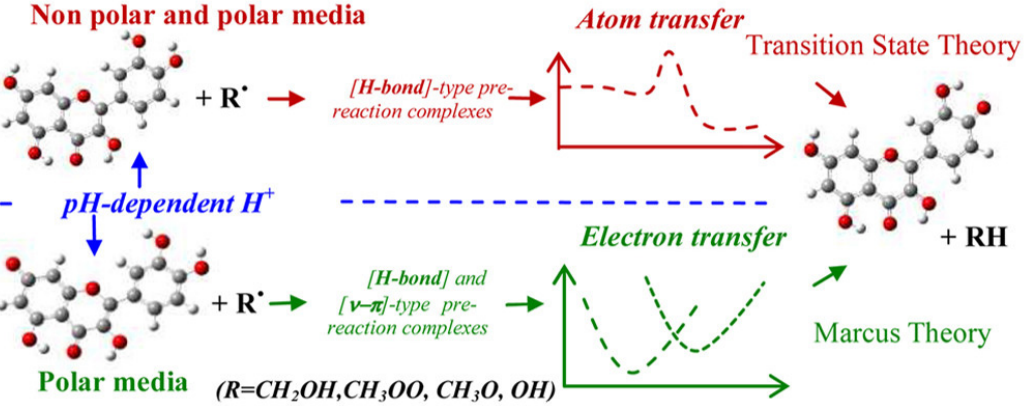
Figure 6. Schematic depiction of the hydrogen atom transfer (HAT) mechanism. Reprinted (adapted) with permission from [89]. Copyright 2023 American Chemical Society.